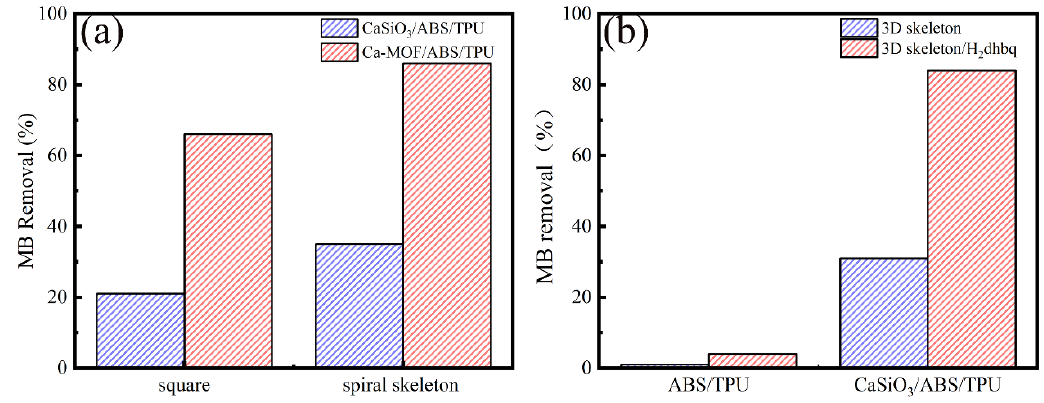
Figure 6. ( a ) Comparison of different models, ( b ) MB adsorption capacity of ABS/TPU and CaSiO 3 /ABS/TPU